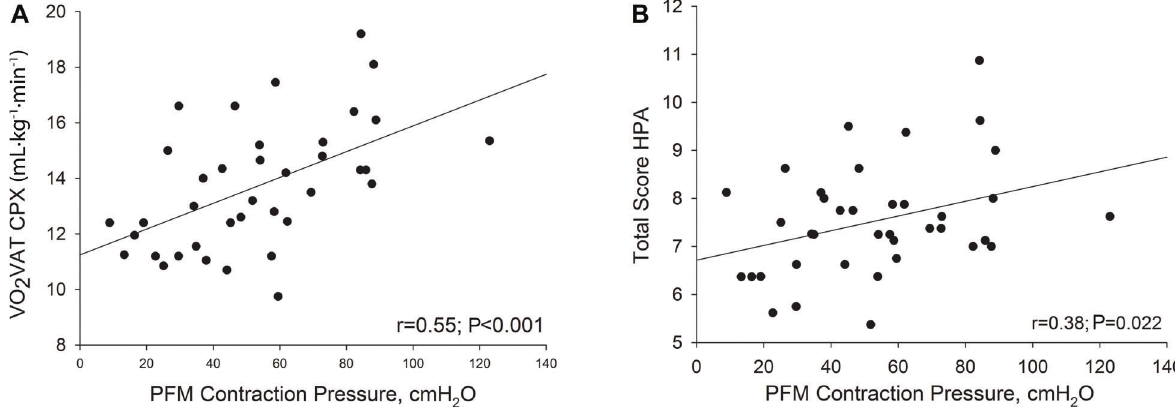
Figure 2. A , Correlation between pelvic fl oor muscles (PFM) contraction pressure and oxygen consumption (VO 2 ) at the ventilatory anaerobic threshold (VAT) obtained from the cardiopulmonary exercise test (CPX). B , Correlation between PFM contraction pressure and habitual physical activity (HPA) score.